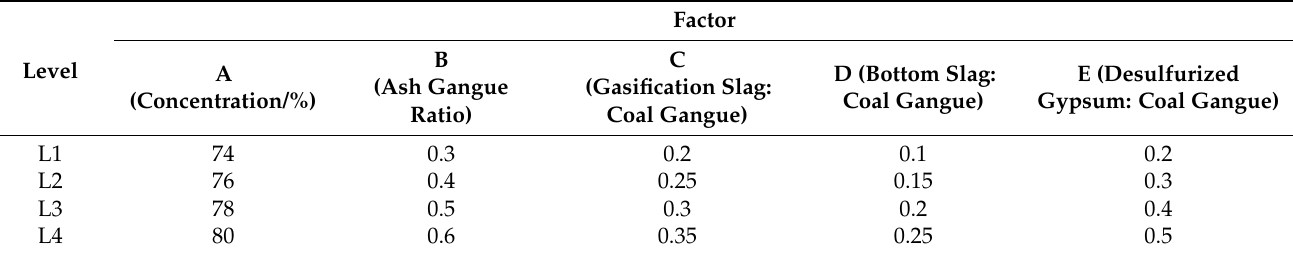
Table 1. L16(4 5 ) orthogonal experimental factors and